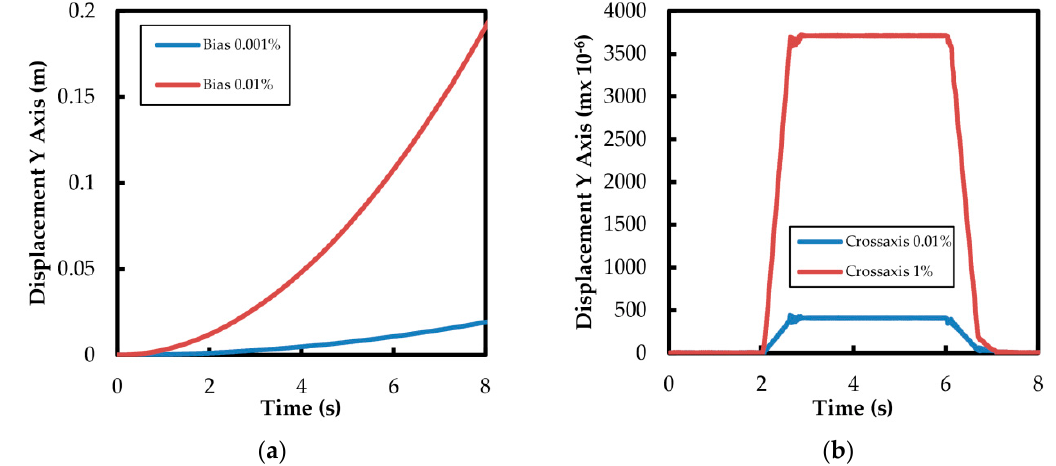
Figure 14. Calculated displacement for Y axis; ( a ) bias and ( b ) cross-axis sensitivity error evaluation.